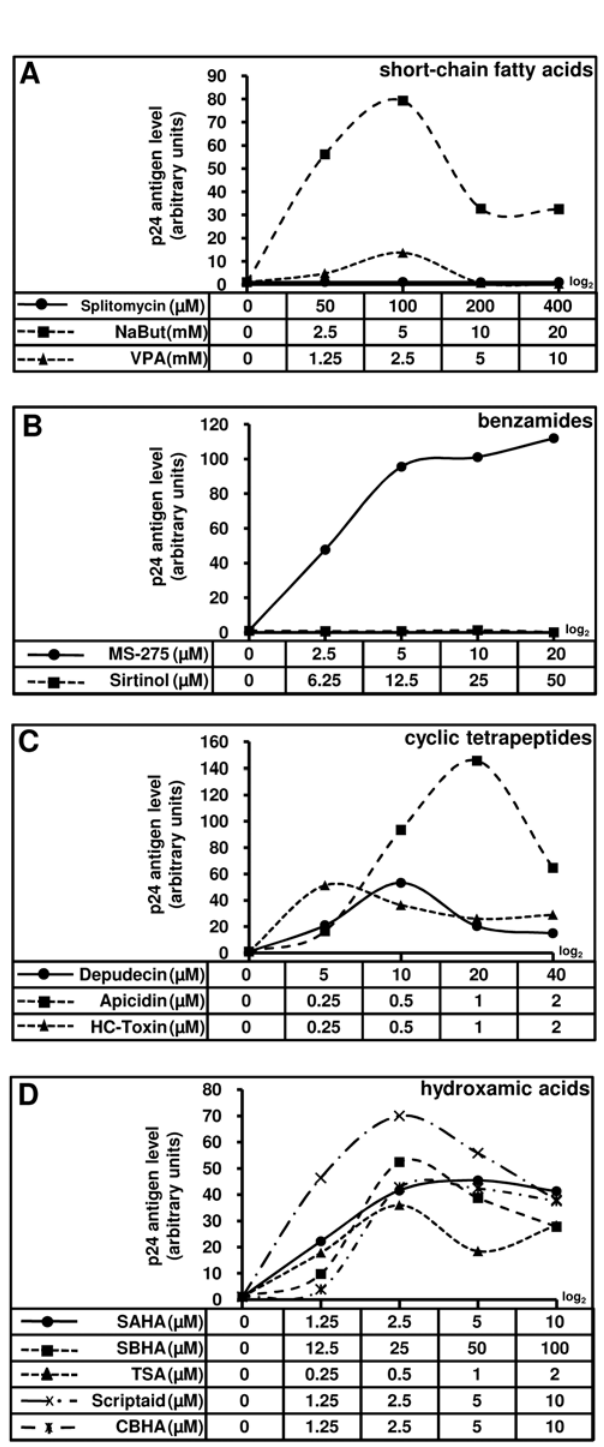
Figure 1. Dose-dependent effects of various HDACIs on HIV-1 production. U1 cells were mock-treated or treated with HDACIs: short- chain fatty acids ( A ), benzamides ( B ), cyclic tetrapeptides ( C ), hydroxamic acids ( D ). At 24 h posttreatment, viral production was estimated by measuring CA-p24 antigen concentration in culture supernatants. The mock-treated value was arbitrarily set at a value of 1. Each point is the mean from three separate experiments performed in triplicate. SE are intentionally not represented on the graph for clarity reasons.